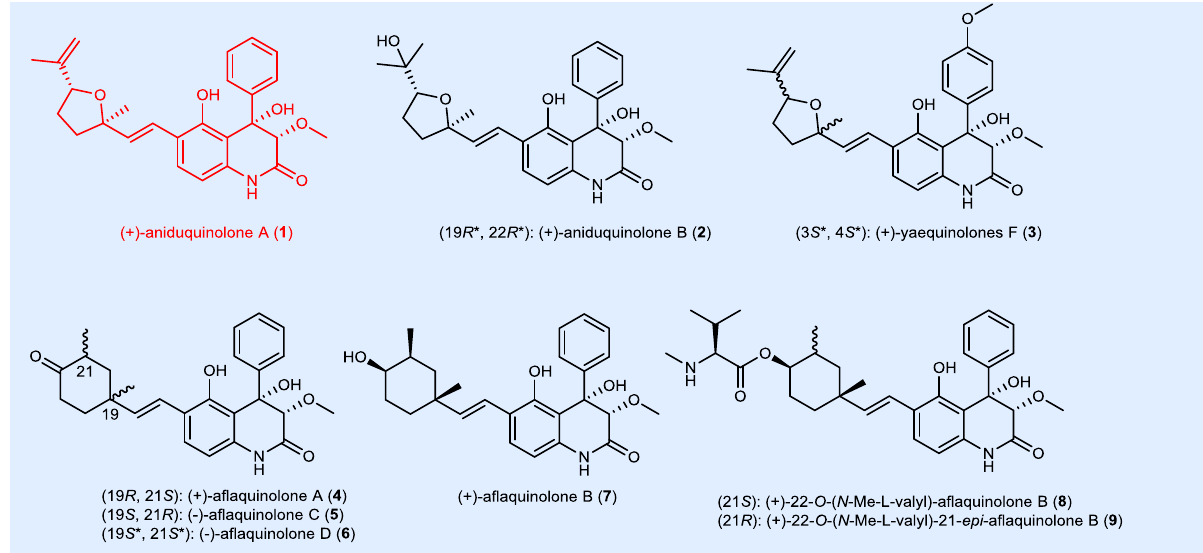
Fig. 1 Examples of bioactive quinolones. Representatives of the 3,4-dioxygenated 5-hydroxy-4-aryl-quinolin-2(1 H )-one